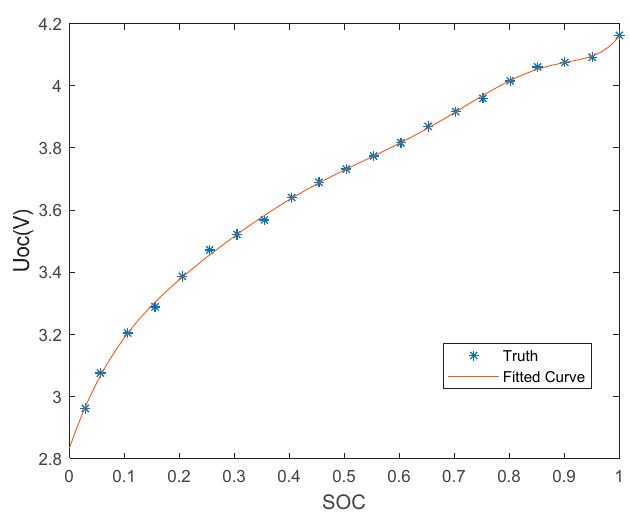
Figure 3. U oc –SOC fitting U –SOC fitting curve. Figure 3. oc